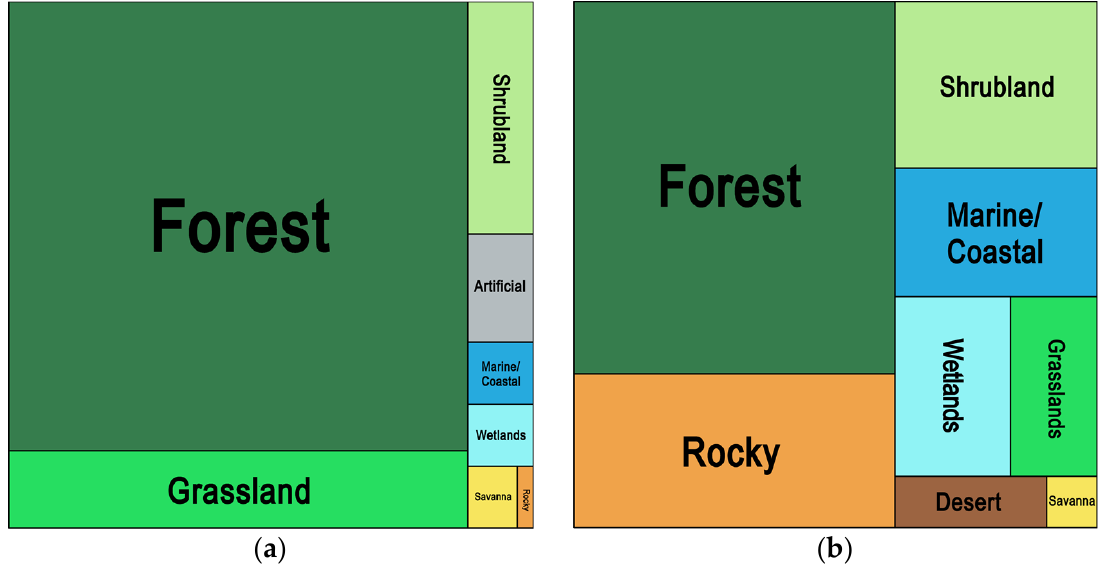
Figure 8. Proportion of threatened ( a ) nonlichenized fungi (n = 272) and ( b ) lichens (n = 106) in the different main habitats. Note that species may be present in more than one habitat.